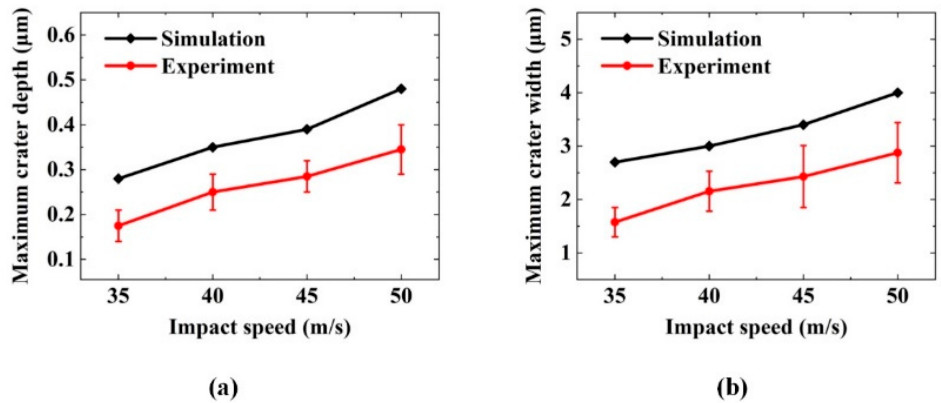
Figure 7. Comparison of experimental results and simulation: ( a ) change in maximum depth of crater and ( b ) change in maximum width of crater. crater and ( b ) change in maximum width of